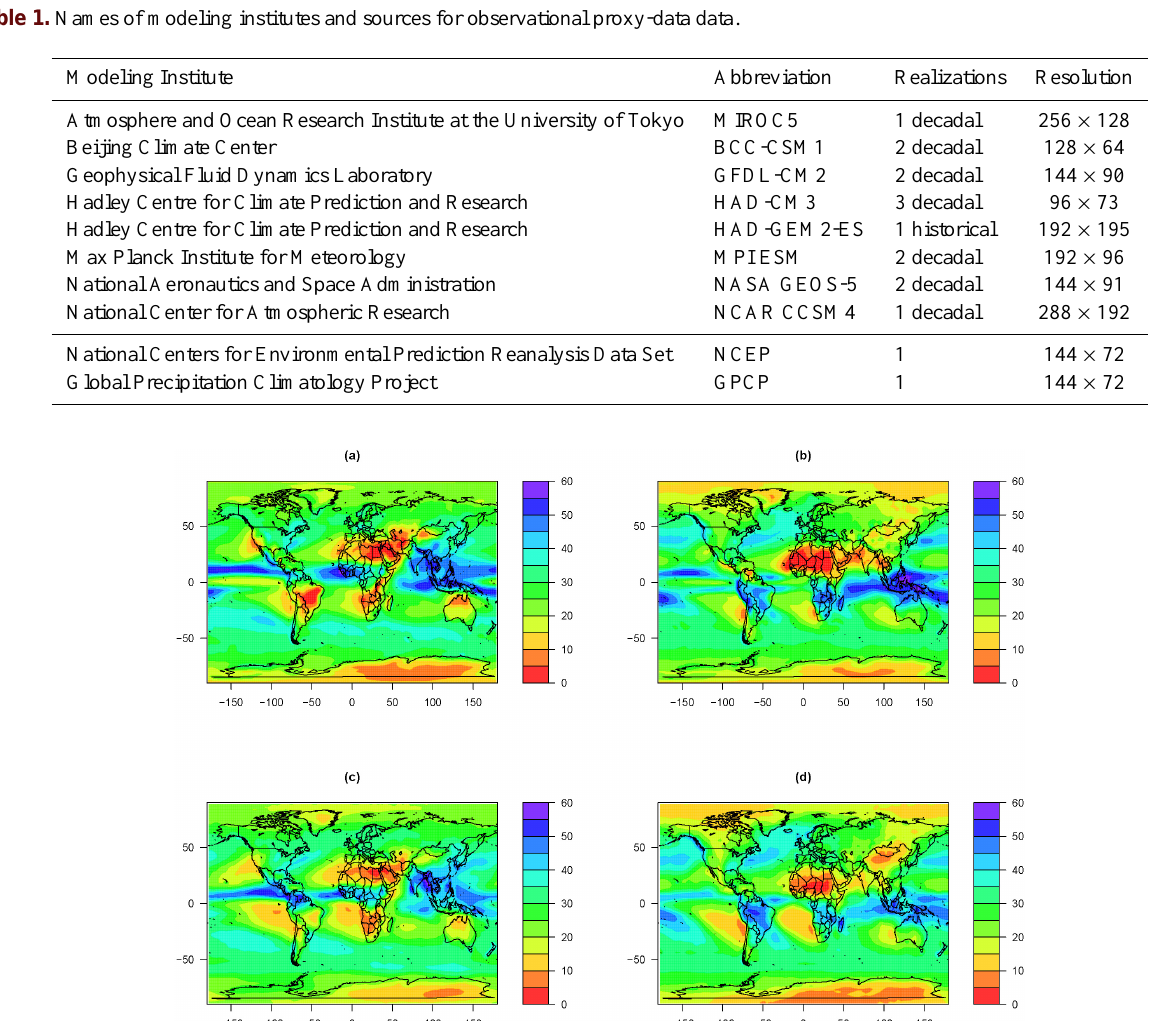
isotropic covariance structure implies that the covariance be- tween two spatial locations only depends on the distance be- tween the two locations (see Sect. 3.2 for more formal defi-